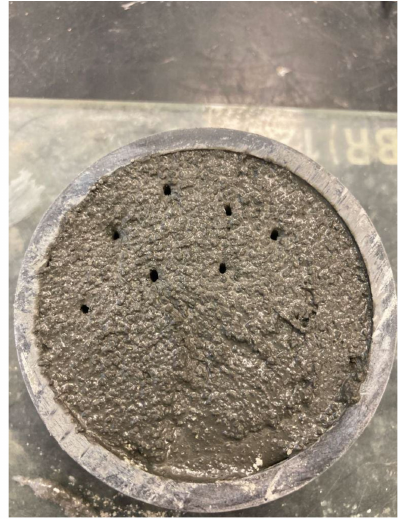
Figure 2. Gap generated in paste indicating the start of setting